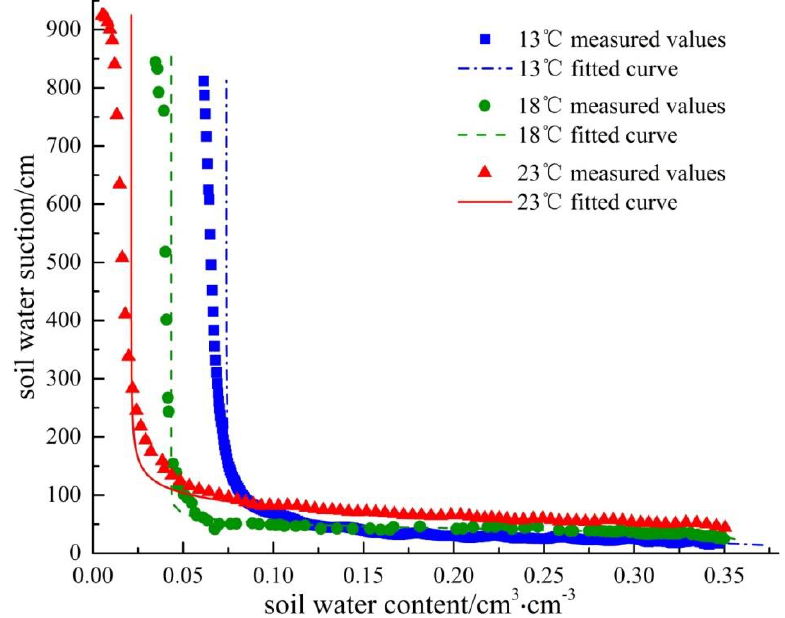
Figure 6. Measured data points and fitting curves from the Ku-pF experiment.